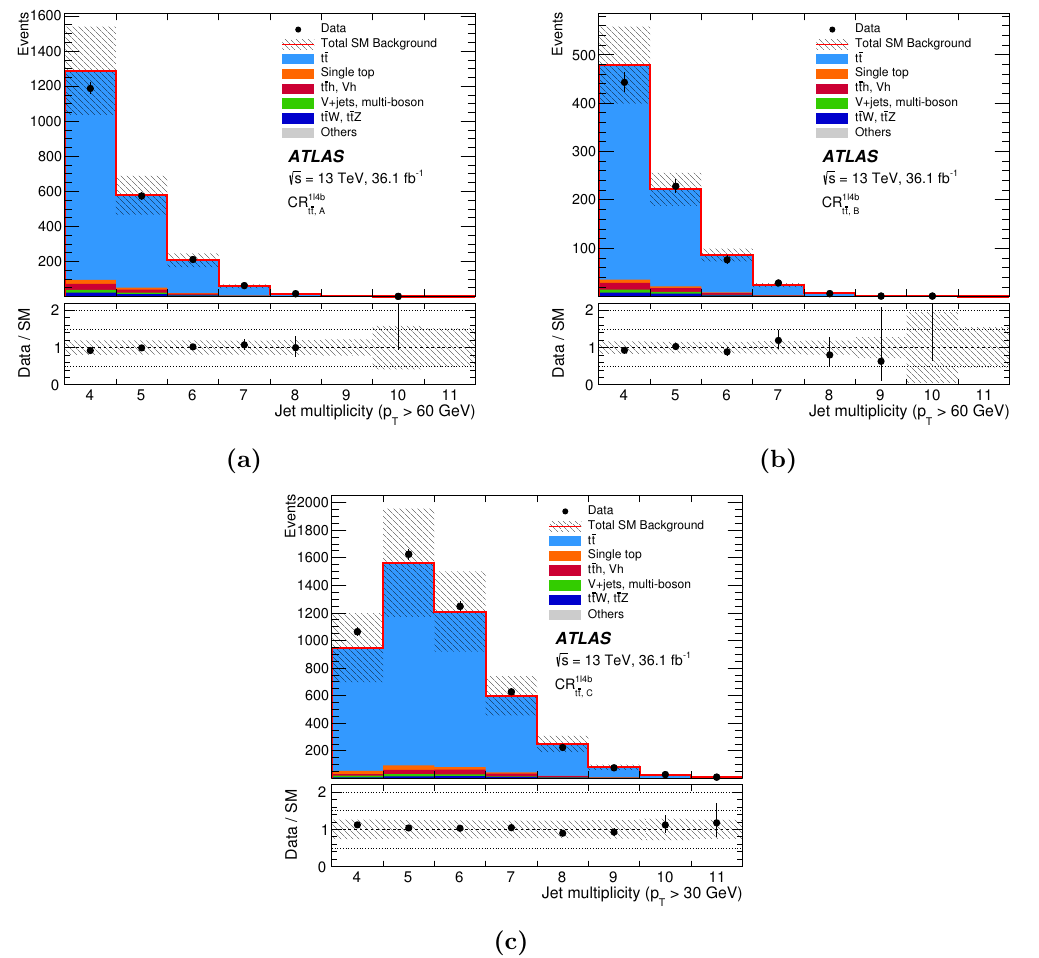
Figure 3. Jet multiplicity distributions in control regions (a) CR 1 ‘ 4 b after normalising the t (cid:22) t background process via the simultaneous (cid:12)t described in section 5. The t (cid:22) t background normalisation is constrained to the data observation for jet multiplicity values above the requirements shown in table 6. The contributions from all SM backgrounds are shown as a histogram stack; the bands represent the total uncertainty. The \Others" category contains the contributions from t (cid:22) th , t (cid:22) tWW , t (cid:22) tt , t (cid:22) tt (cid:22) t , Wh , and Zh production. The last bin in each (cid:12)gure contains the over(cid:13)ow. The lower panels show the ratio of the observed data to the total SM background prediction, with the bands representing the total uncertainty in the background